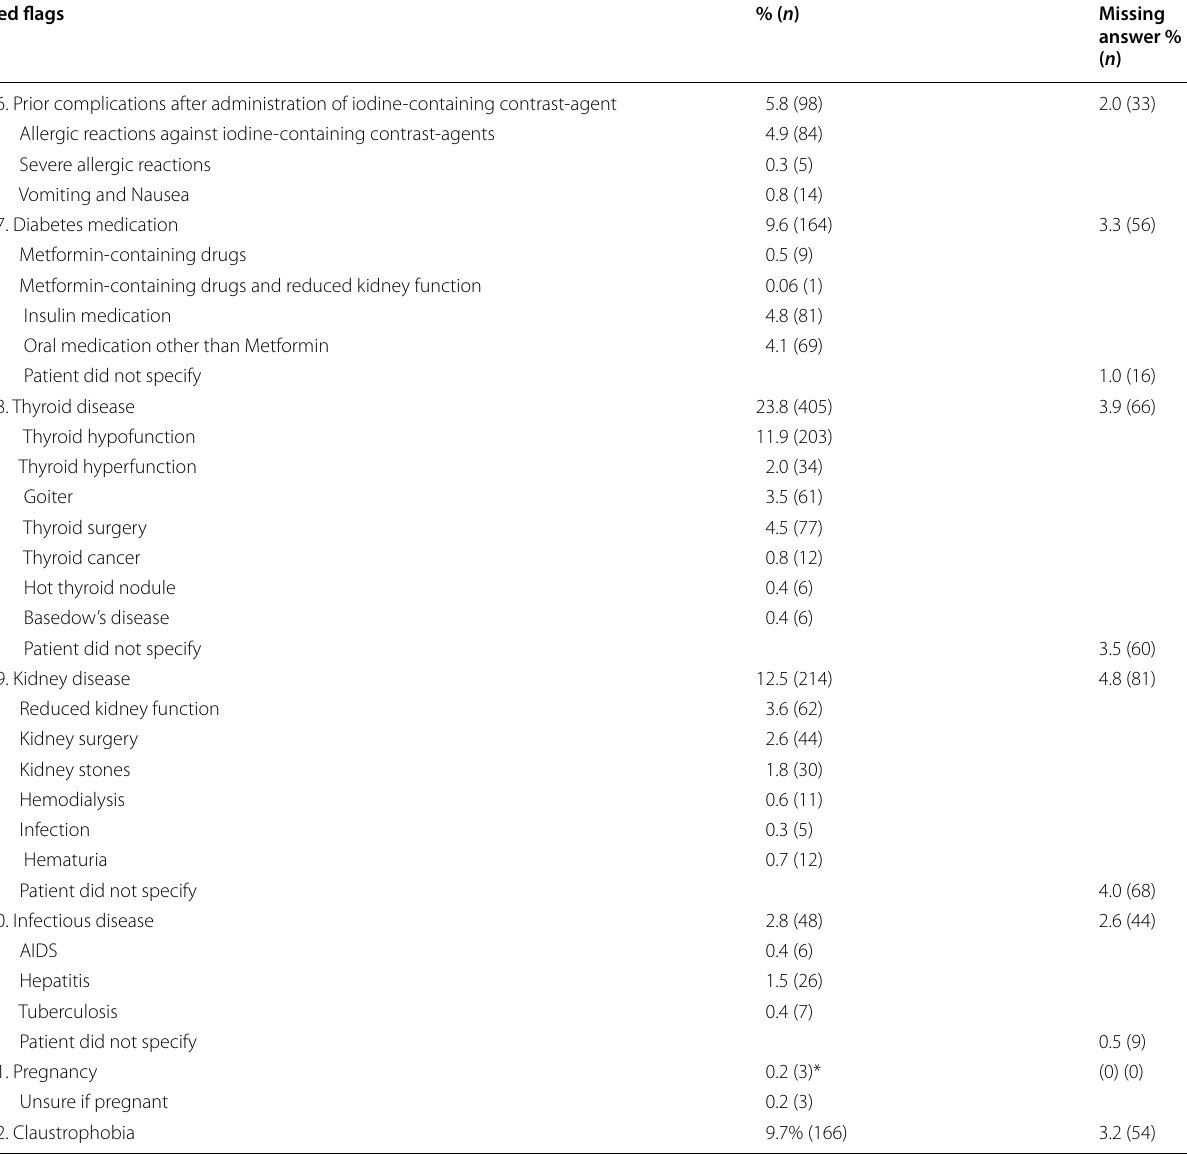
Table 4 Prevalence of red flags about relative and absolute contraindications for contrast-enhanced computed